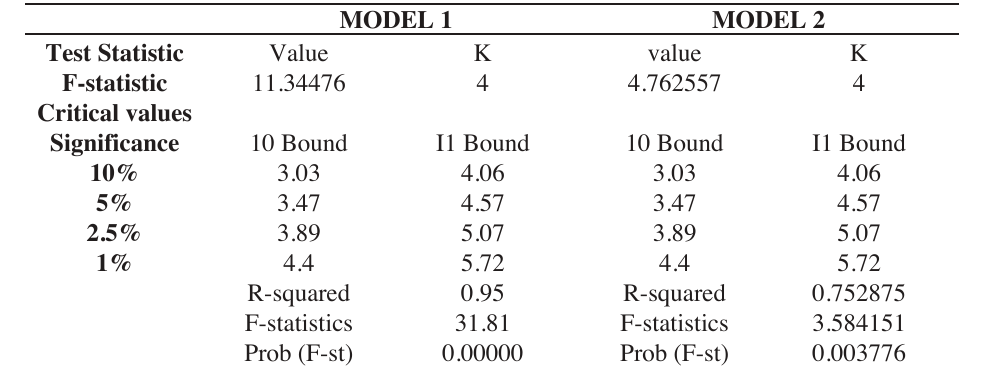
Table 4: Bound test for co integration results MODEL 1 MODEL